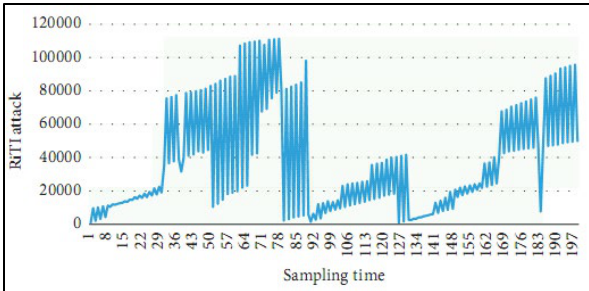
Figure 10. Features of RITI for Attack Traffic flow